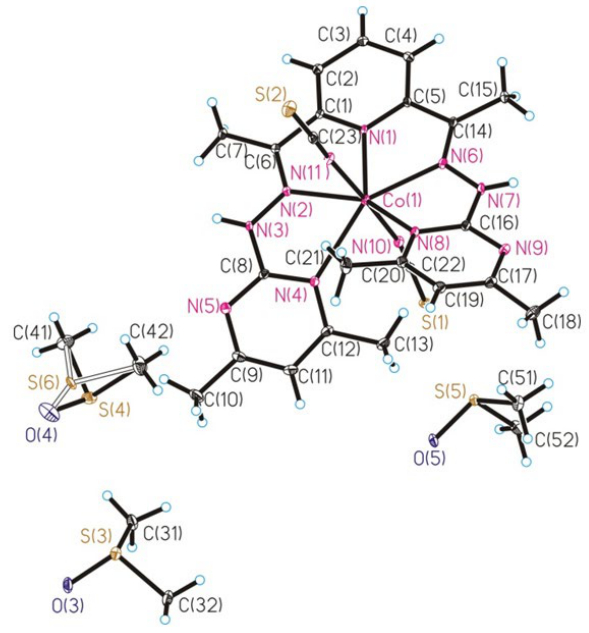
Figure 1. Molecular structure and atom-numbering scheme of compound 1 (for convenience, the same atom numbering is used when discussing complexes 2 , 2a , and 3 ).